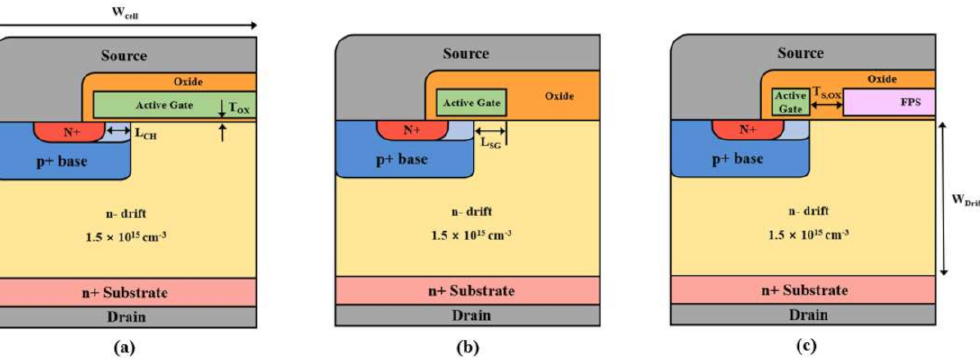
Figure 1. Schematic cross-sectional views of the MOSFETs. ( a ) C-DMOSFET (conventional pla- nar DMOSFET); ( b ) SG-DMOSFET (split-gate DMOSFET); ( c ) FPS-DMOSFET (floating p+ polysili- con